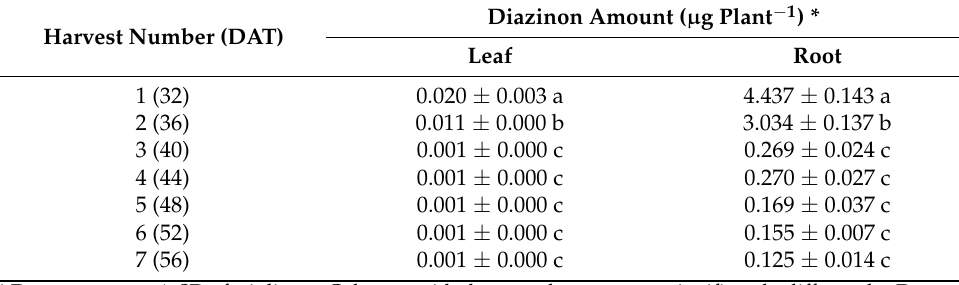
Table 4. Residual amounts of diazinon in lettuce during the harvest.